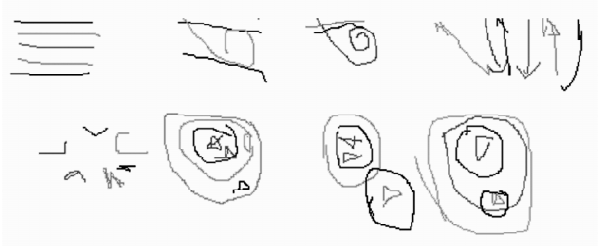
Figura 3 . Episódio das Carreiras: representação